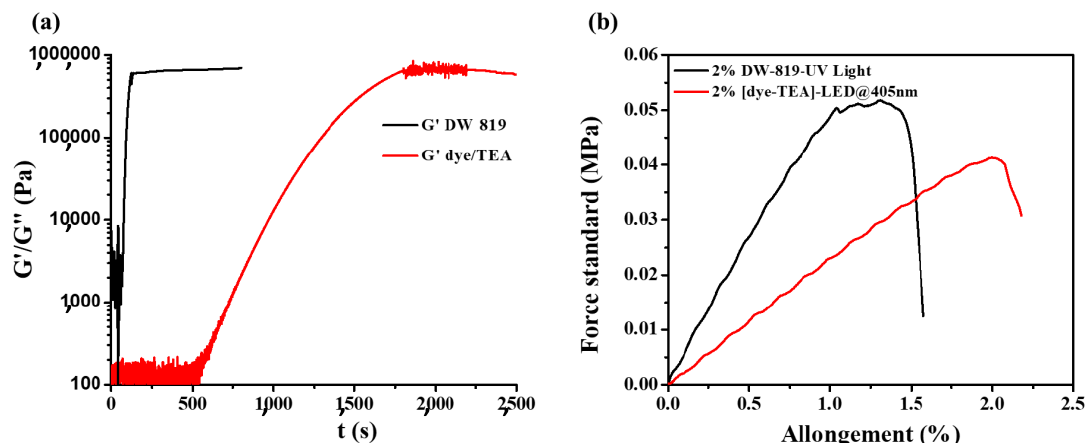
Figure 4. ( a ) The storage (G′) modulus of hydrogels obtained with 2 wt% Omnirad 819 DW under LED @ 365 nm and 2 wt% [dye-TEA] under LED @ 405 nm; ( b ) Tensile test of hydrogels obtained with 2 wt% Omnirad 819 DW under a LED @ 365 nm irradiation and 2wt% [dye-TEA] upon irradiation with the LED @ 405 nm.